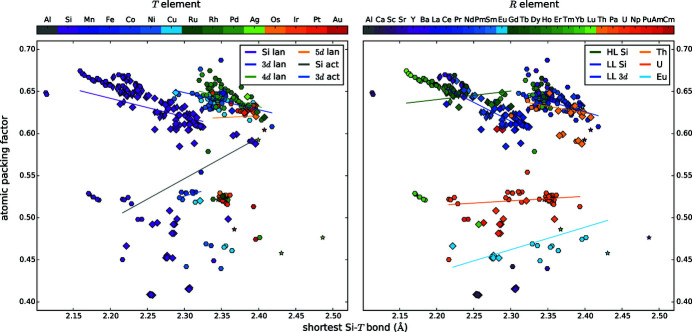
Correlations between the atomic packing factor and the shortest Si—T distance d. The apf is mainly determined by the R element, visible in the almost horizontal lines for the R elements Th, U and Eu.